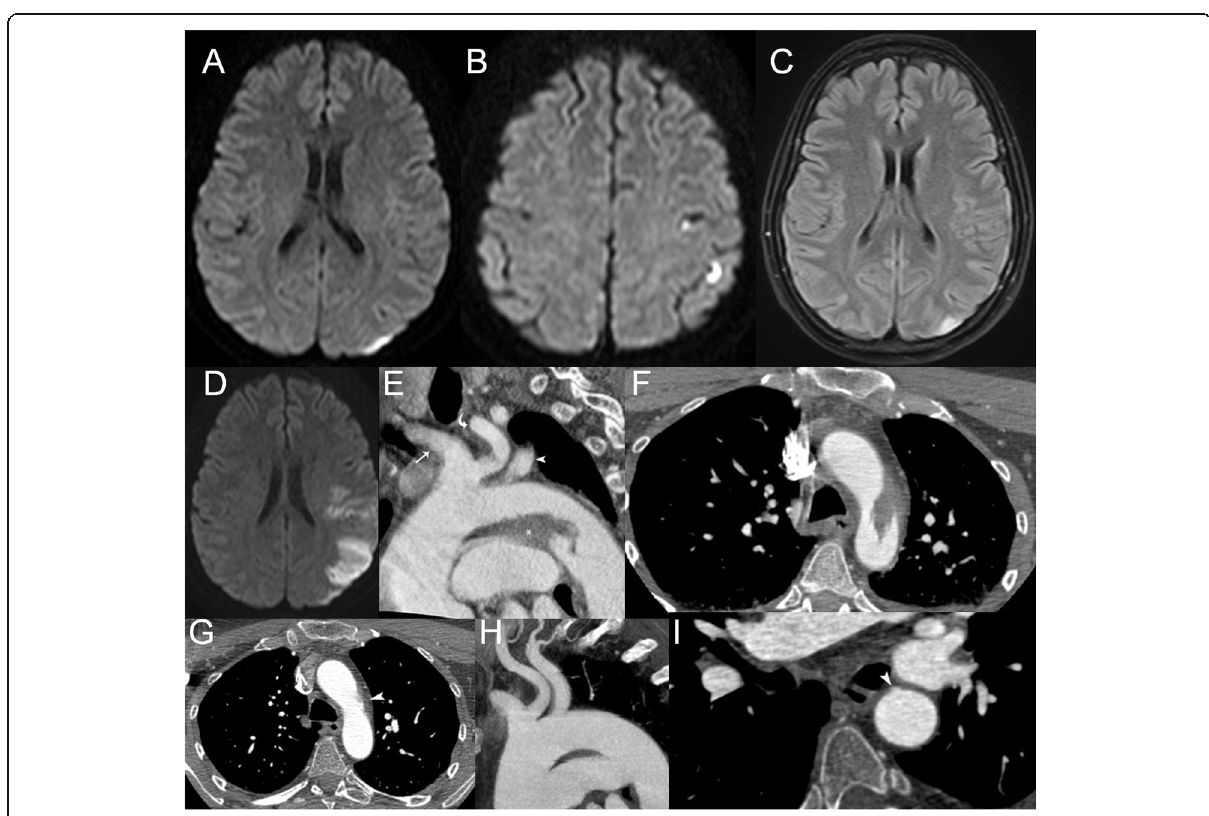
Fig. 1 Baseline and follow-up brain MRI and CT angiography of the aortic arch. Figure Legend. Axial brain DWI showing minor foci of restricted diffusion in the parietal cortical territory of the left MCA ( a - b ) . There is total matching of the lesion size between DWI and FLAIR images ( c ). Repeat axial brain DWI showing a recurrent infarction in the posterior left MCA territory ( d ). Oblique sagittal reformatted CT angiography showing a broad-based thrombus (asterisk) situated at the inferior wall of the aortic arch, facing the origin of the great vessels. Notice the origin of the left common carotid artery (curved arrow) from the brachiocephalic trunk (arrow), so-called “ bovine arch ” , and the origin of the left subclavian artery (arrowhead) ( e ). Axial CT angiography showing the floating intraluminal thrombus as a flame-like filling defect attached to the wall of the aortic arch ( f ). Follow-up reformatted axial ( g ) and sagittal ( h ) CT angiography confirming complete dissolution of the thrombus after anticoagulation. Notice the mild subjacent atheroma (arrowhead) that nested the thrombus. Follow-up oblique axial CT angiography demonstrating an outpouching of the contrast medium (arrowhead), representing a shallow ulceration in the subjacent atheroma ( i